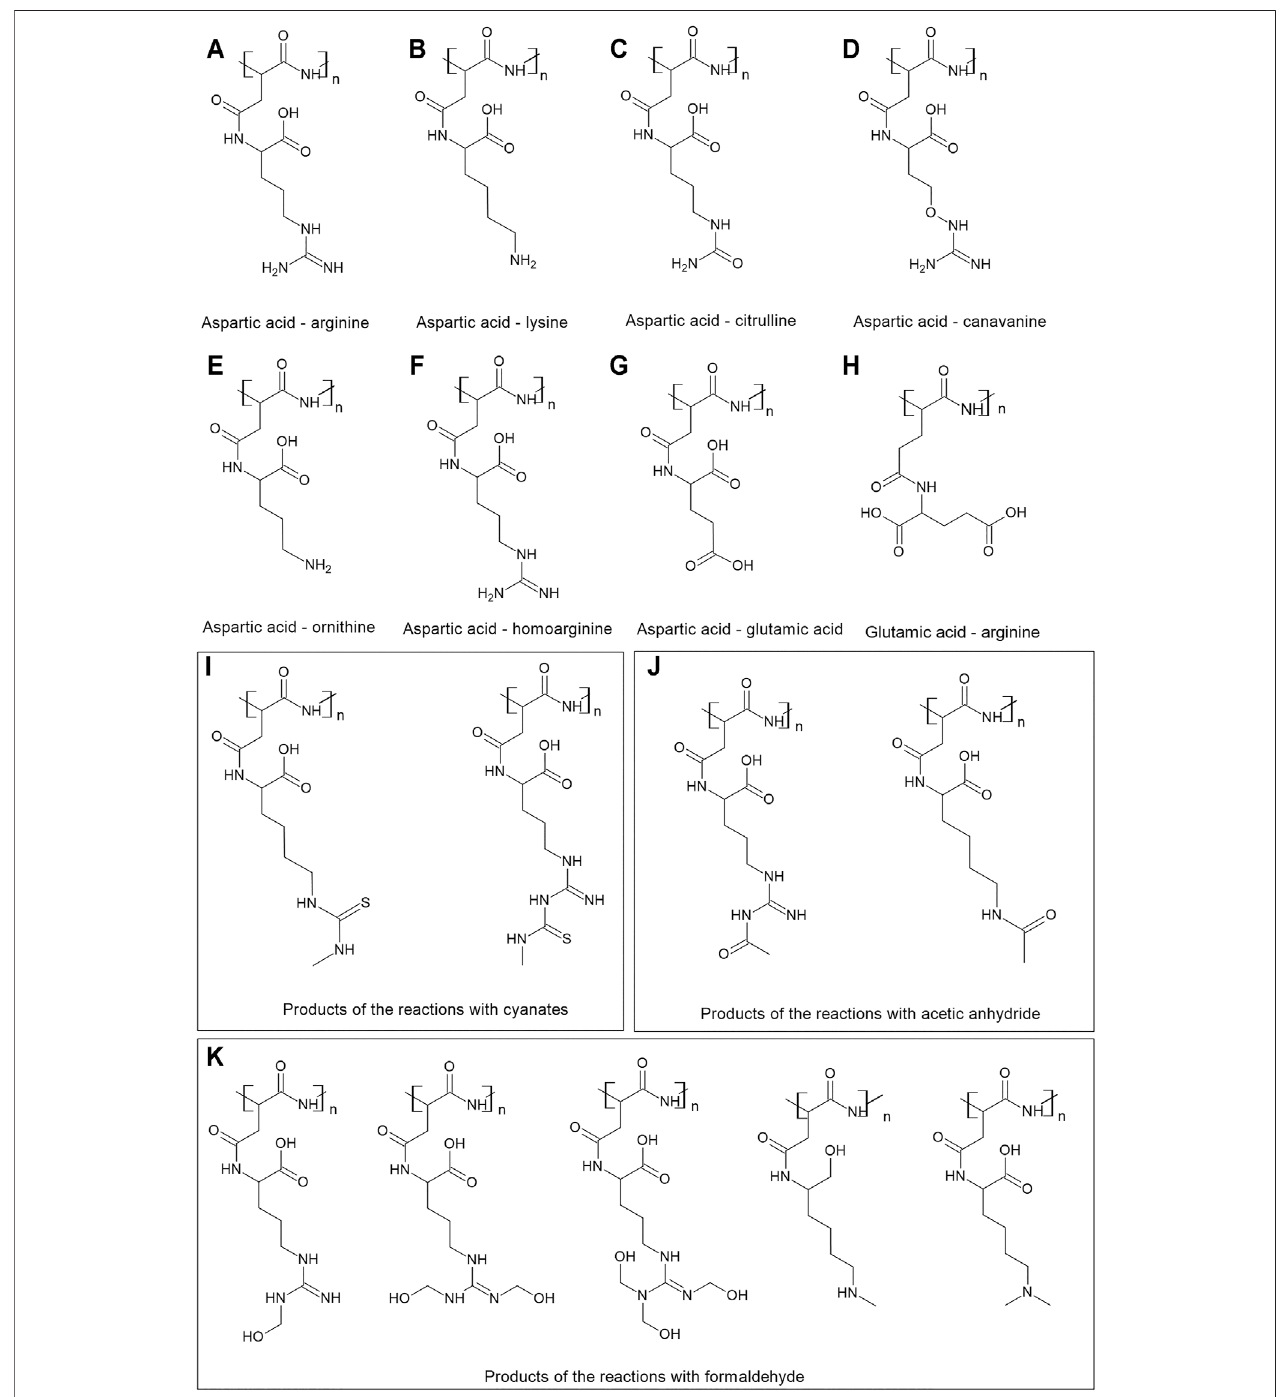
FIGURE 1 | Cyanophycin and its modi fi cations. (A) The basic structure of cyanophycin – aspartic acid in the backbone and arginine in the side chain; the next drawings present cyanophycin with aspartic acid in the backbone and different side chains: (B) lysine, (C) citrulline, (D) canavanine, (E) ornithine, (F) homoarginine, (G) glutamic acid. (H) glutamic acidin the backbone and arginine in the sidechain. The drawings I-K presents the structuresofthe products ofthe reactions ofcyanophycin with (H) cyanates, (I) acetic anhydride (J) formaldehyde.